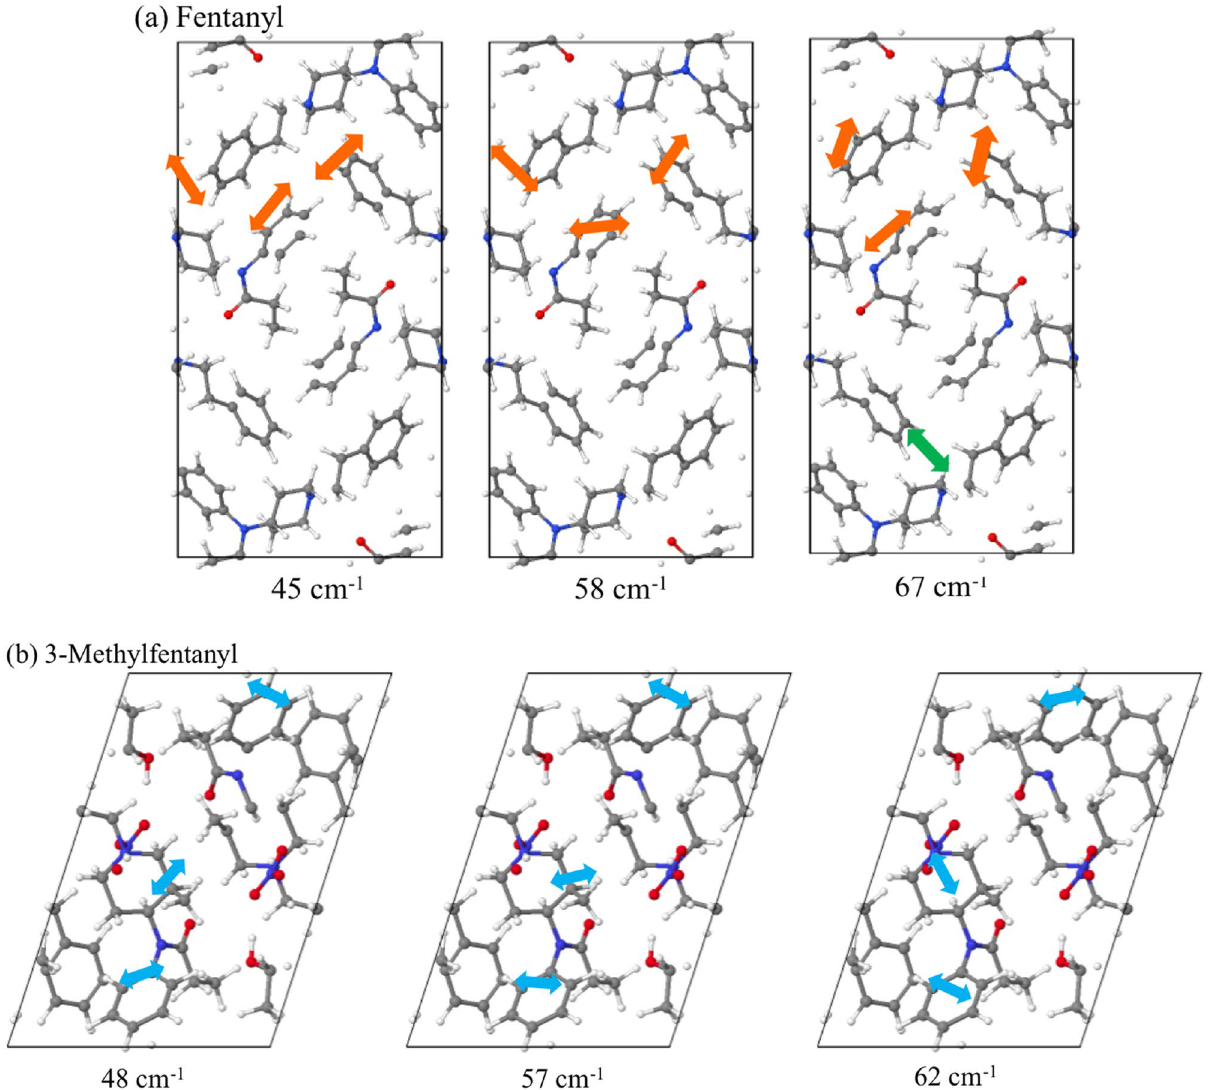
Figure 3. Normal modes of fentanyl in ( a ) 45, 58, and 67 cm −1 along with a-axis. Orange arrows show the vibrational direction of benzene and piperidine. Green arrow shows the formation of N…H H-bond. Normal modes of 3-methylfentanyl in ( b ) 48, 57, and 62 cm −1 along with b-axis. Blue arrows show the vibrational direction of benzene and 3-methylpiperidine. Carbon, hydrogen, nitrogen, and oxygen atoms are depicted as grey, white, blue, and red spheres,